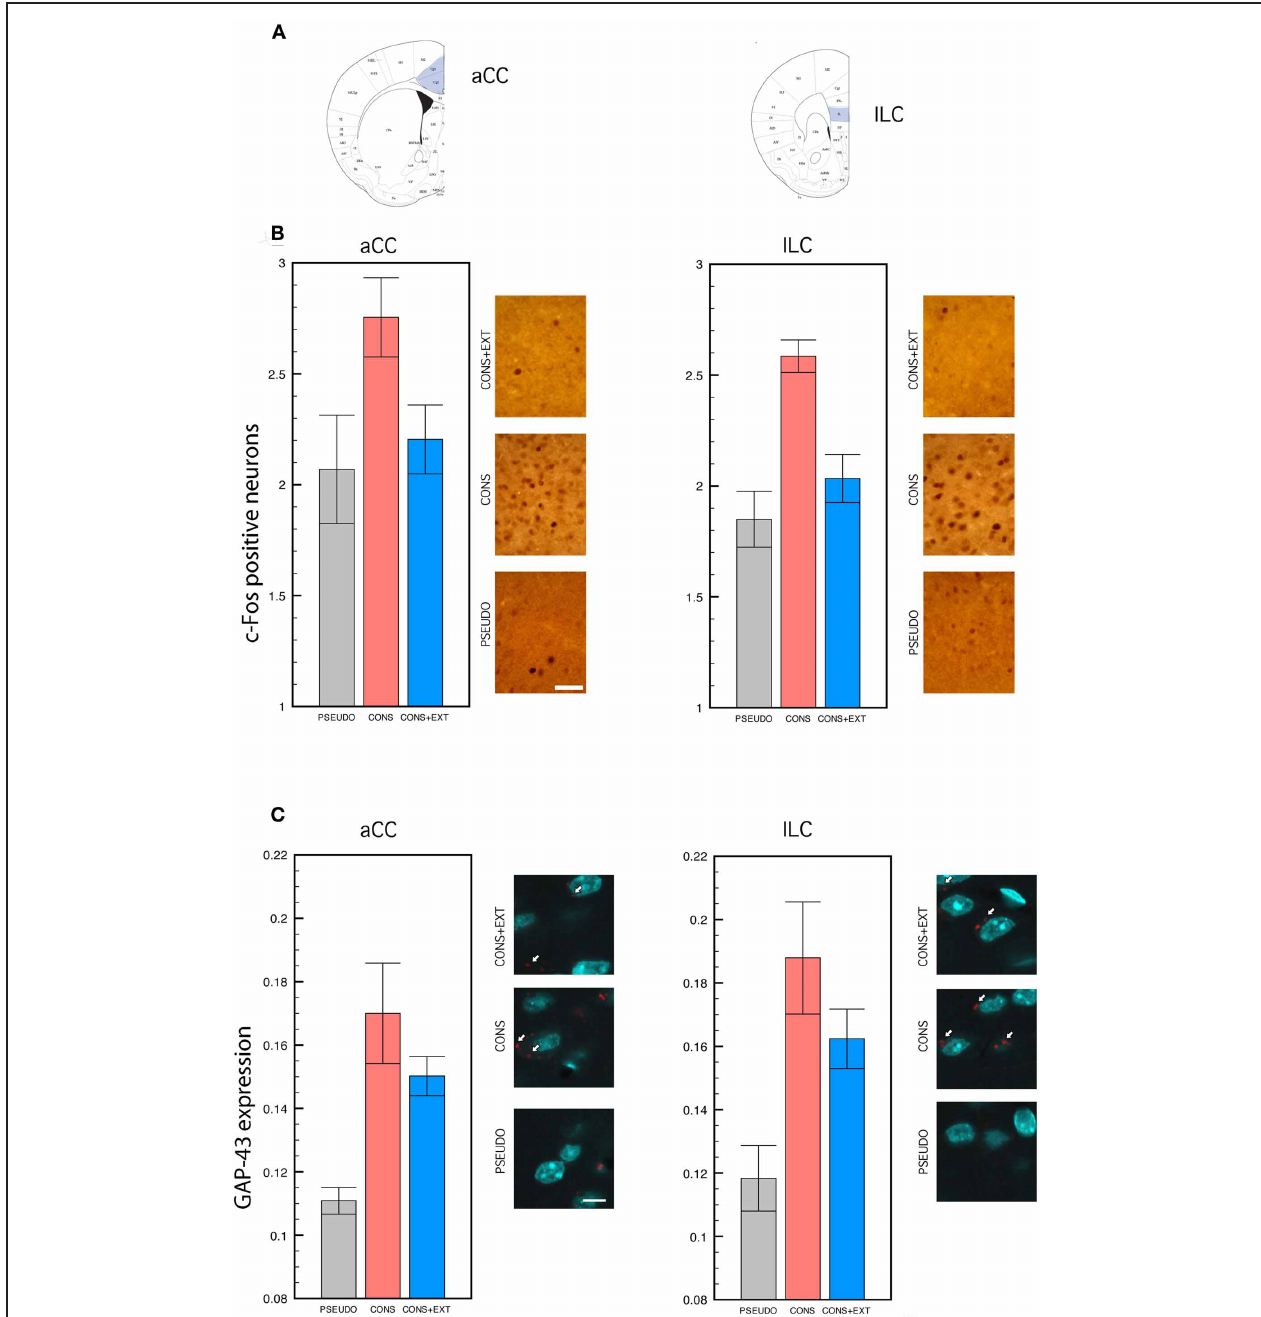
FIGURE 2 | c-Fos immunocytochemistry and GAP-43 immunofluorescence. Statistical comparisons were performed on the raw data. (A) Anatomical delimitation of anterior cingulate (aCC) and infra-limbic (ILC) cortices based on Franklin and Paxinos (2001). (B) c-Fos positive cells counted in the aCC and the ILC of PSEUDO, CONS, and CONS + EXT mice after remote memory testing. In both regions, c-Fos positive cells were significantly more numerous in the CONS group than in the PSEUDO and the CONS + EXT groups among which no difference was found [significant group effect: ( F ( 2 , 32 ) = 10 , 88, P < 0 . 001), CONS vs. PSEUDO or CONS + EXT, P < 0 . 001 for each pair comparison; non-significant ROI effect: